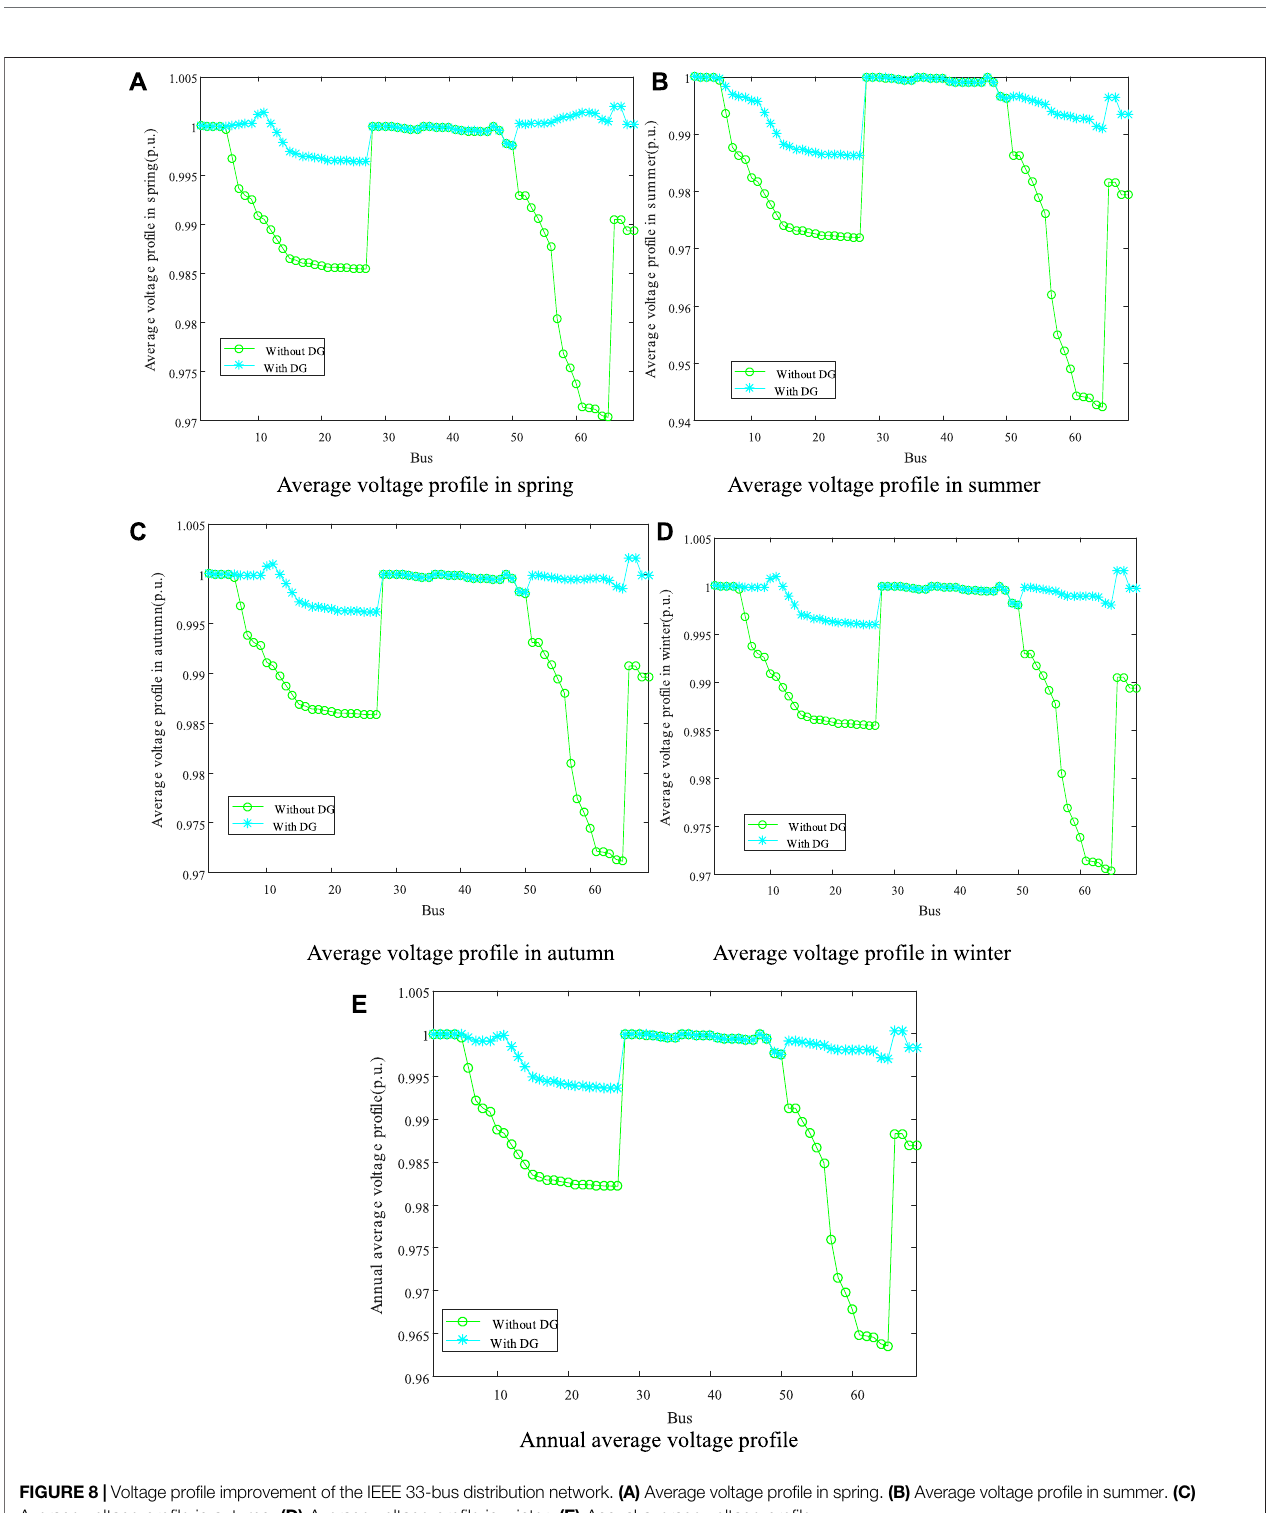
Frontiers in Energy Research |